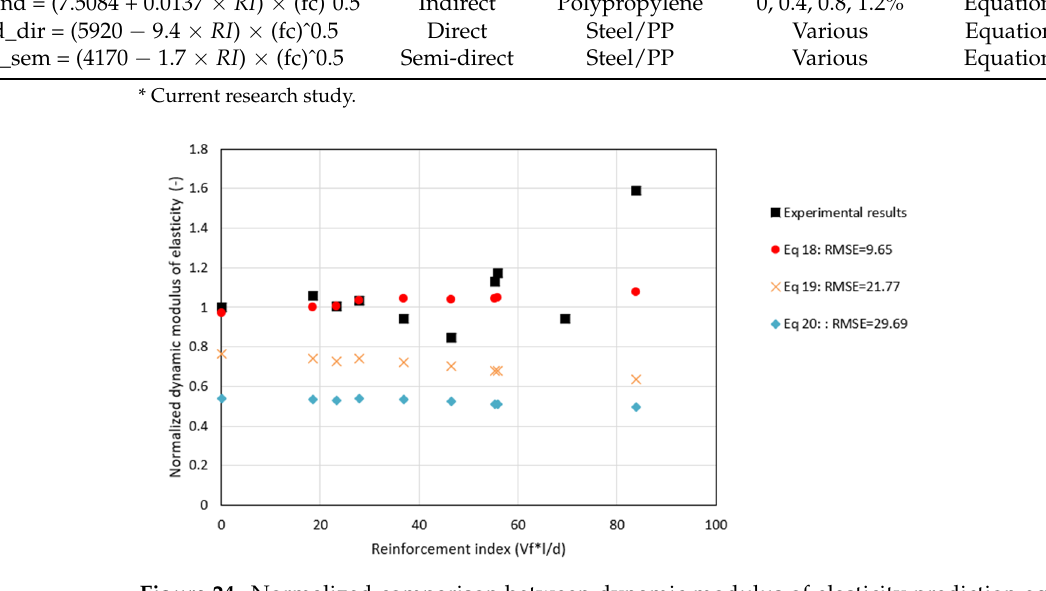
Figure 24. Normalized comparison between dynamic modulus of elasticity prediction equations based on the reinforcement index and compressive strength.